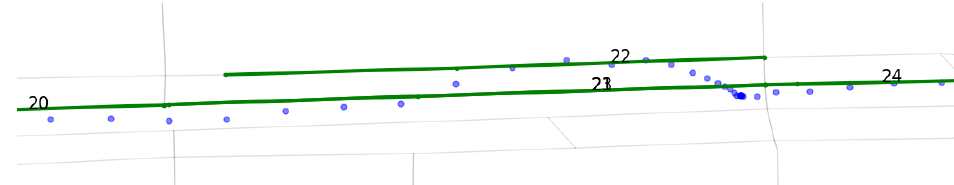
Figure 3. Cat-II error : isolated lane selection.